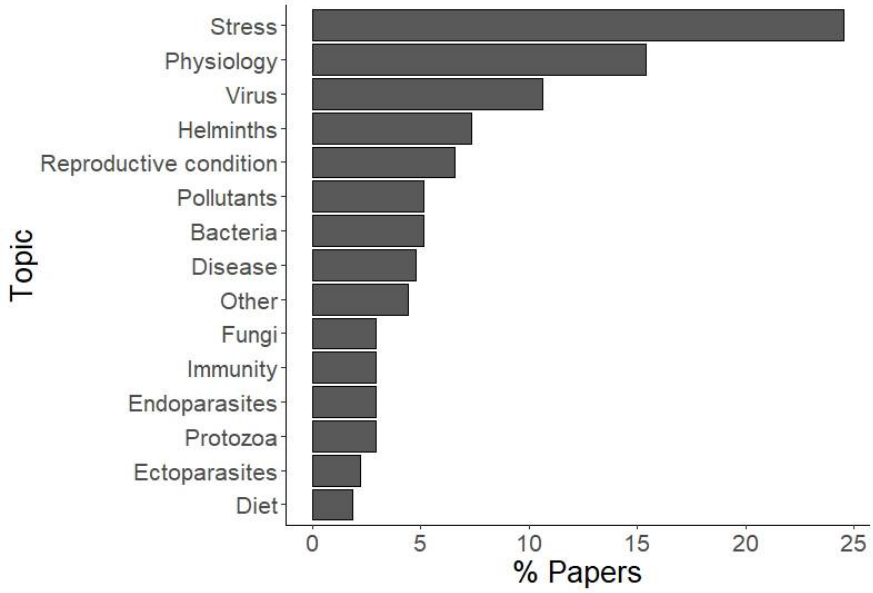
Figure 2. The percentage of published articles per topic. For a definition of categories, see Table 1.